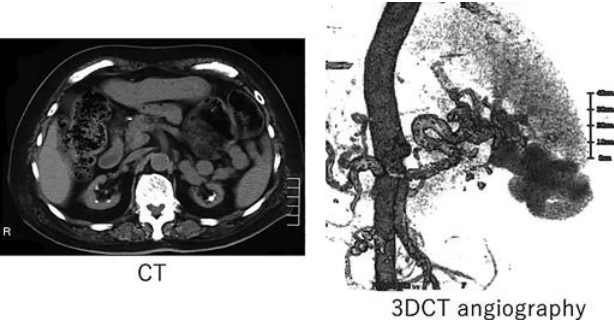
Figure 2 Plain abdominal CT and 3D CT angiography for case 4. Abnormal vessels were found from the splenic vein to the left renal vein in case 4.